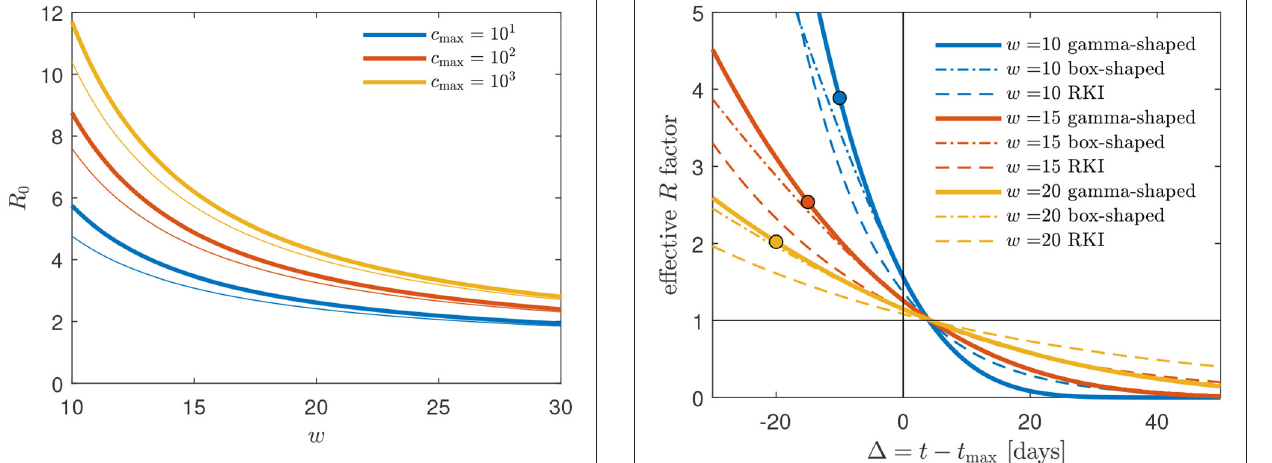
FIGURE 5 | Gamma-shaped R ( t ) (33) compared with the approximate R ( t ) (37) (red, dashed), using a box-shaped serial interval distribution W ( s ), and the RKI formula (41). Cases shown are w 10, w 15, and w 20. Deviations are = = = most pronounced and significant for the smallest w 10. The R ( t ) curves = t 0 corresponding to 1 1 0 , see (5). The circles mark 1 0 for terminate at t = = c max =